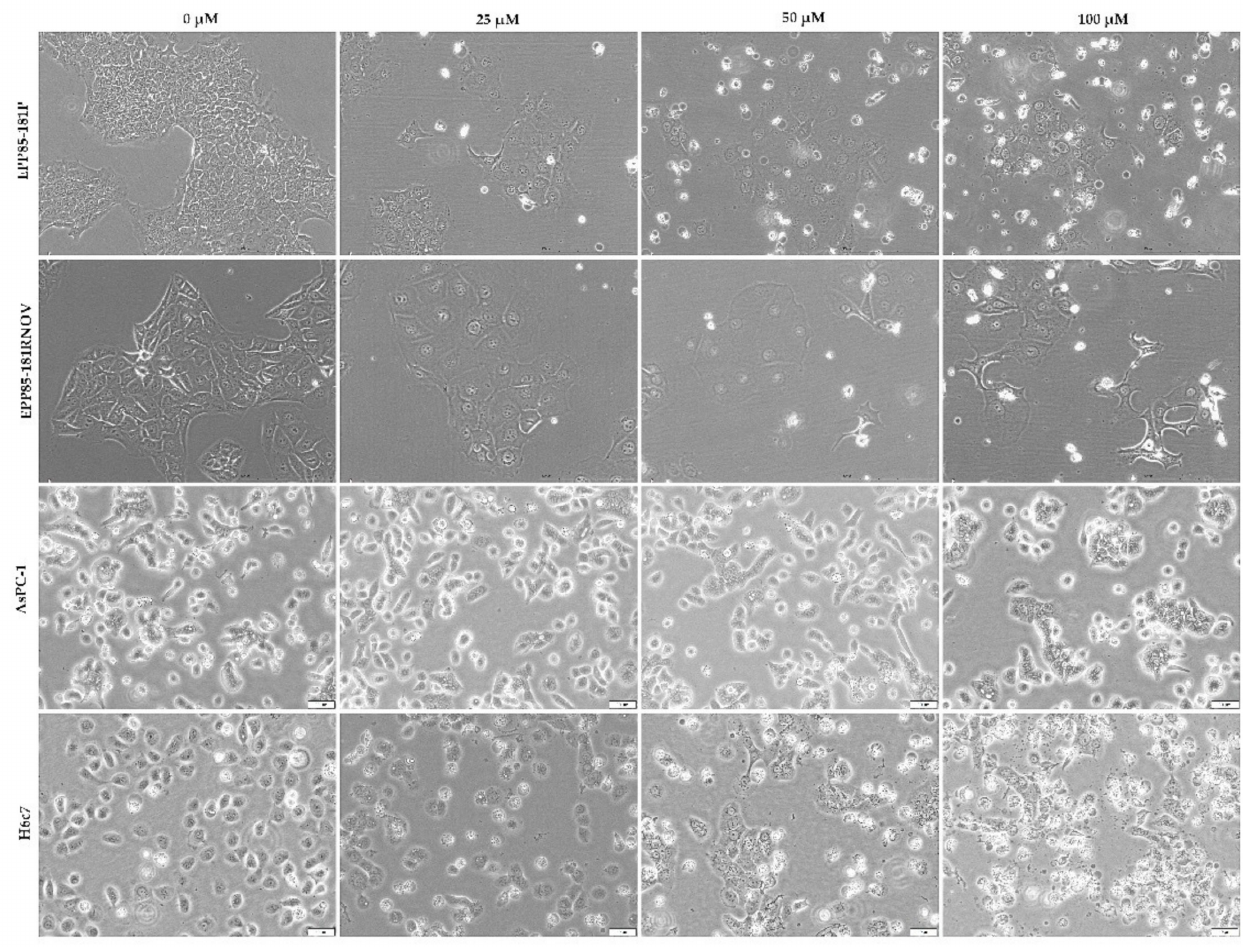
Figure 9. Resveratrol induces morphological changes in EPP85-181P, EPP85-181RNOV, AsPC-1 and H6c7 cells after 48 h incubation with different concentrations of the compound. As the concentration increases, a smaller number of cells can be observed compared to the control, as well as many cells detached (iridescent) from the